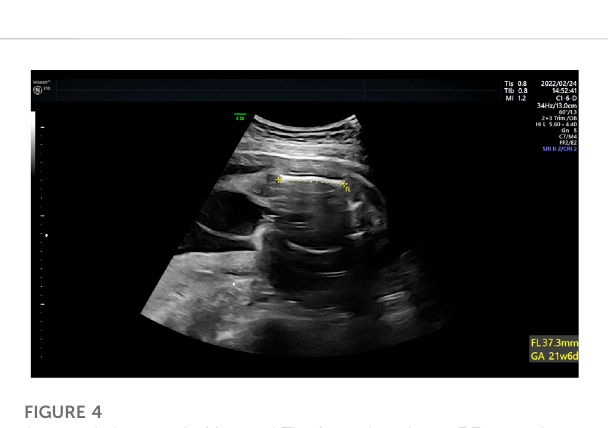
FIGURE 4 Antenatal ultrasound of foetus 4 The femur length was 3.7 cm and slightly